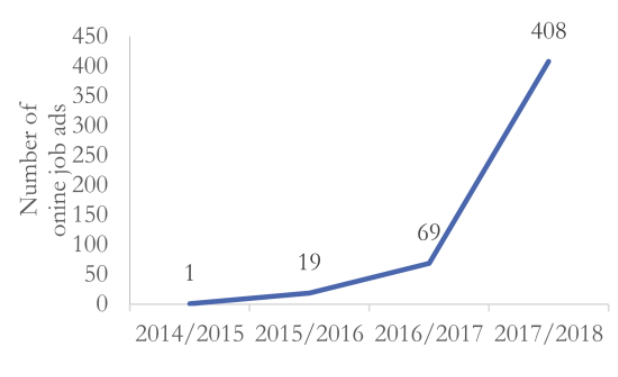
Figure 1. Blockchain-related online jobs ads in Australia, 2014/15–2017/18.